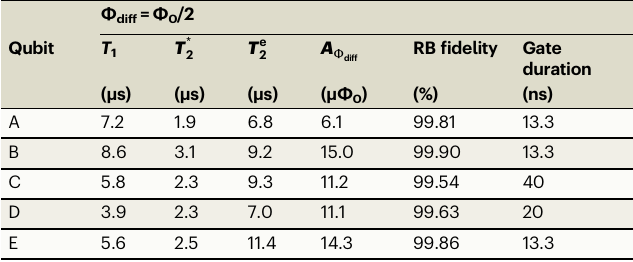
Fig.2c.Themeasuredanharmonicitiesareslightlylower,butveryclose